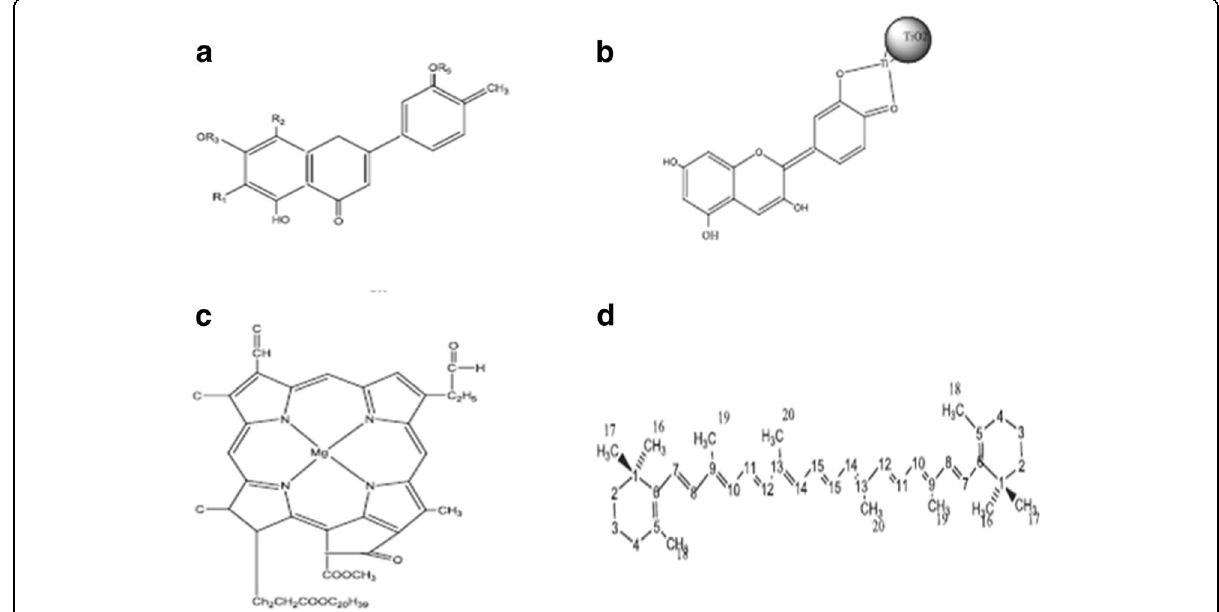
Fig. 23 Chemical structures of a anthocyanin, b flavonoid, c β , β -carotene, and d